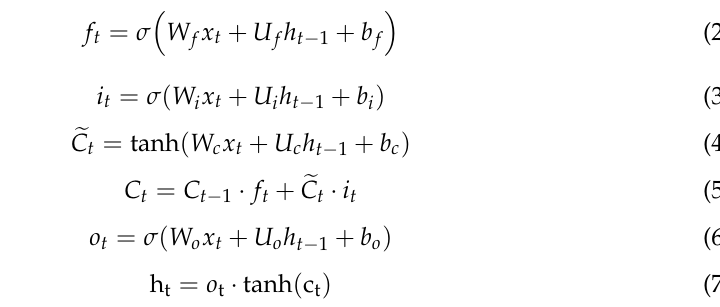
Figure 4. Second-order GCN implementation process.